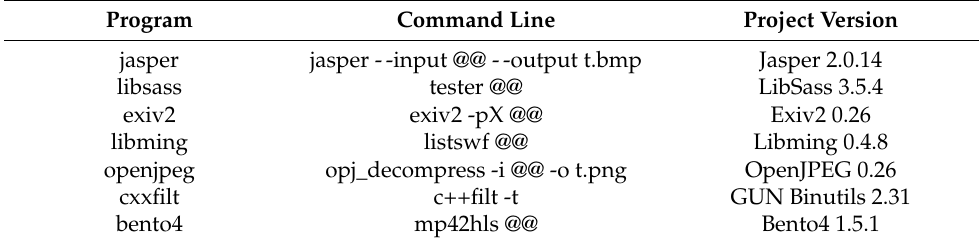
Table 2. Target applications and their fuzzing configure.